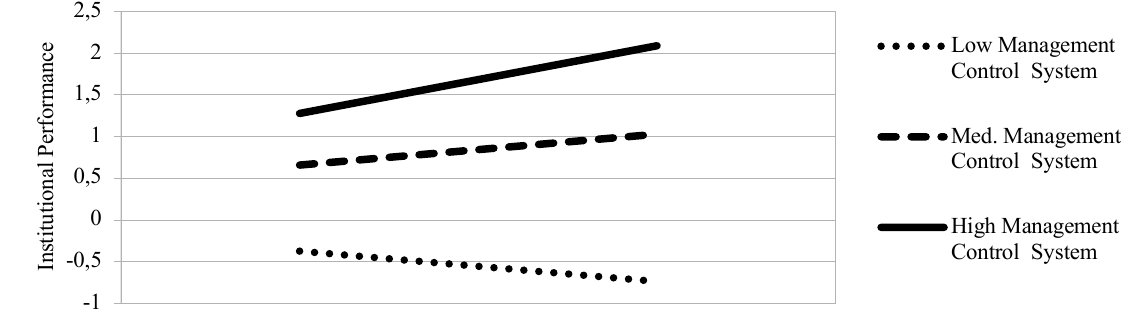
Figure 2: MMR slopes; Organizational Process and Institutional